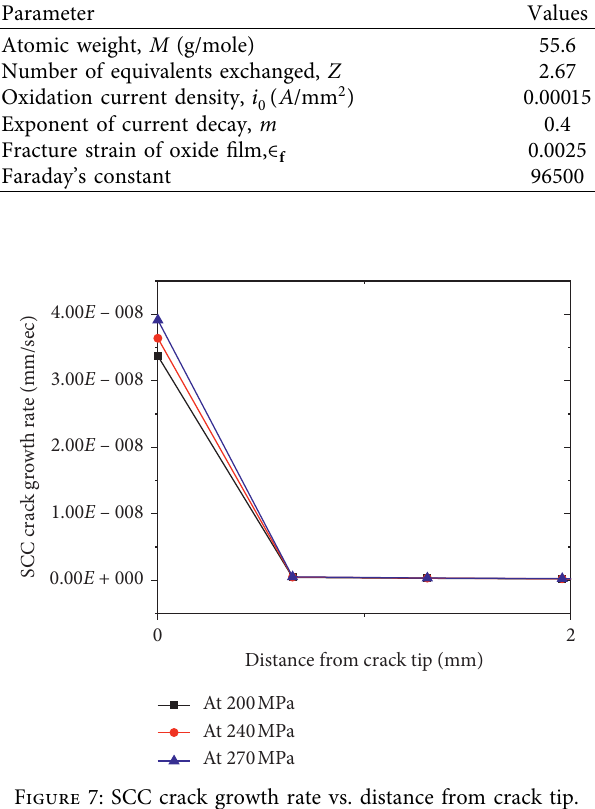
Figure 7: SCC crack growth rate vs. distance from crack tip.